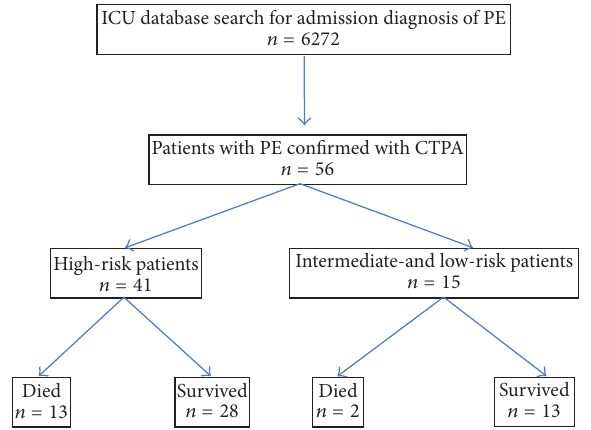
Figure 1: Study flowchart and ICU outcome of the study cohort (CTPA:computertomographypulmonaryangiography;ICU:inten- sive care unit; PE: pulmonary embolism).